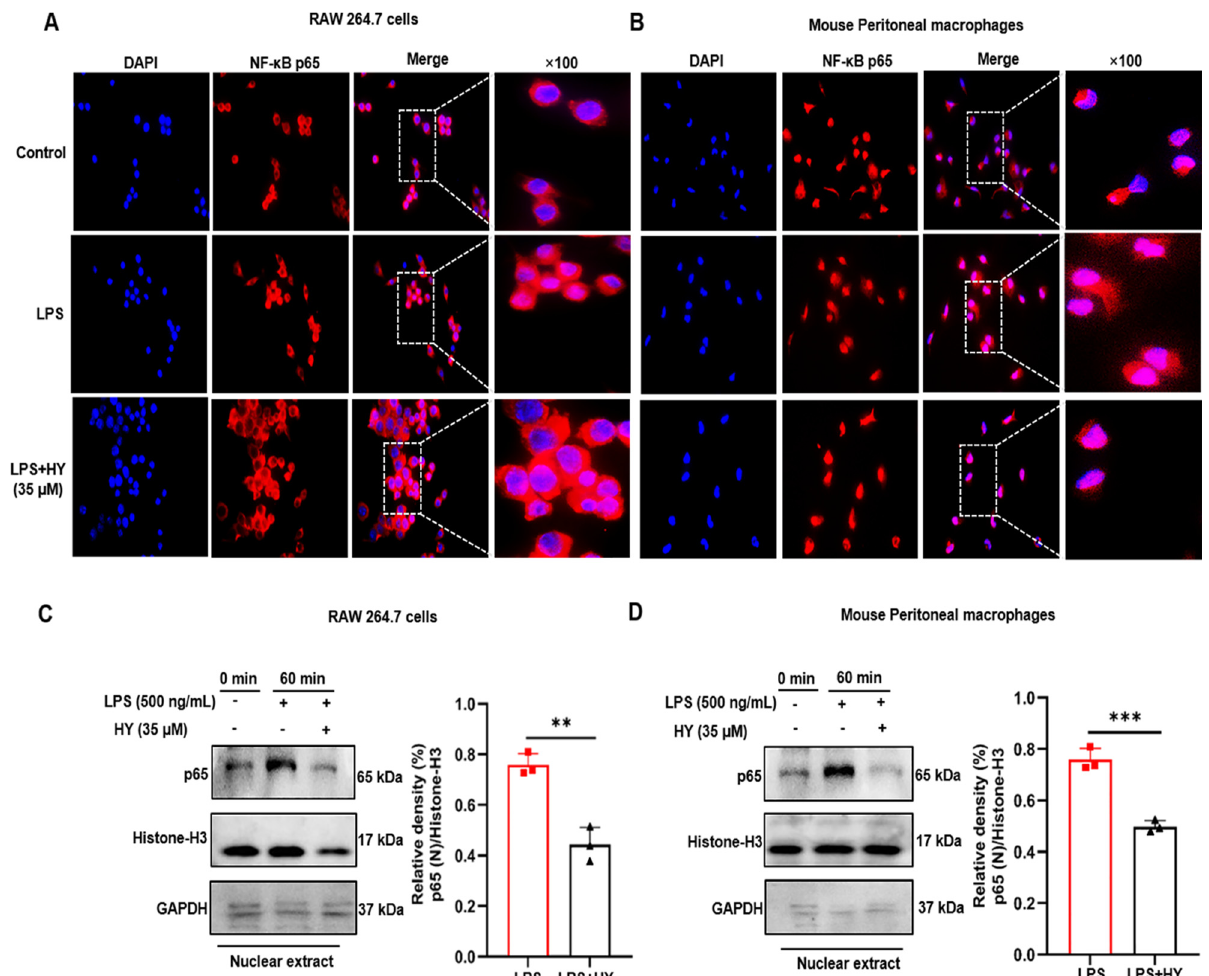
Figure 5. ( A ) The inhibitory effect of hyssopuside (HY) on nuclear localization of nuclear factor-kappa B (NF- κ B) p65 in RAW 267.4 cells. ( B ) The inhibitory effects of HY on nuclear localization of NF- κ B p65 in mouse peritoneal macrophages. Representative images from immunofluorescence assay showing NF- κ B staining (red) in untreated cells, lipopolysaccha- ride (LPS)-stimulated cells, and HY-treated cells stimulated with LPS. Nuclei (blue) were stained with 4 ′ ,6-diamidino-2- phenylindole (DAPI). The micrographs were captured at 100 × magnification, and data are representative of three replicates. ( C ) Western blot analysis for the inhibitory effect of HY on the expression of p65 in RAW 264.7 cells treated with 35 µM HY with 500 ng/mL LPS for 1 h and quantitative of p65. ( D ) Western blot analysis for the inhibitory effect of HY on the expression of p65 in mouse peritoneal macrophages treated with 35 µM HY with 500 ng/mL LPS for 1 h and quantitative of p65. Nuclear and cytosolic extracts were isolated, and the levels of p65 in each fraction were determined by Western blotting. Histone-H3 was detected as a nuclear internal control, and glyceraldehyde 3-phosphate dehydrogenase (GAPDH) was used as a cytosolic internal control. The histogram shows relative density ratios (fold changes) measured by ImageJ. Data are representatives of three replicates and shown as mean ± SD. ** p < 0.01, *** p < 0.001 versus the LPS